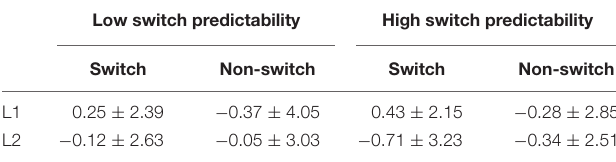
TABLE 4 | Mean amplitudes and standard errors of the late phase elicited by